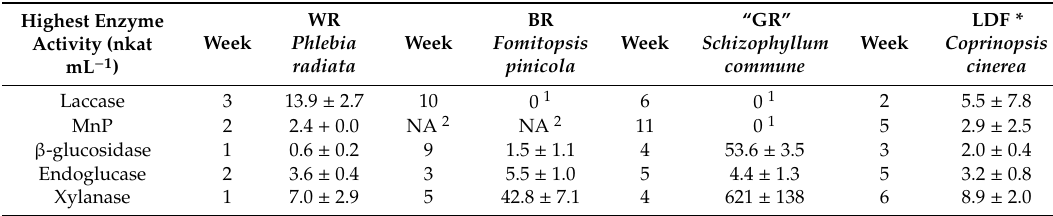
Table 2. Highest enzyme activities (nkat mL − 1 ) measured in the solid-state lignocellulose cultivations on birch wood or barley straw. Mean values of three biological replicate cultures with standard deviation are